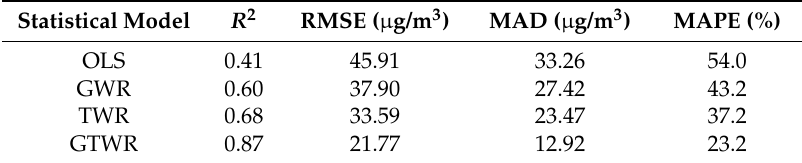
Table 3. Quantitative assessment of cross-validation via OLS, GWR, TWR, and GTWR. Statistical